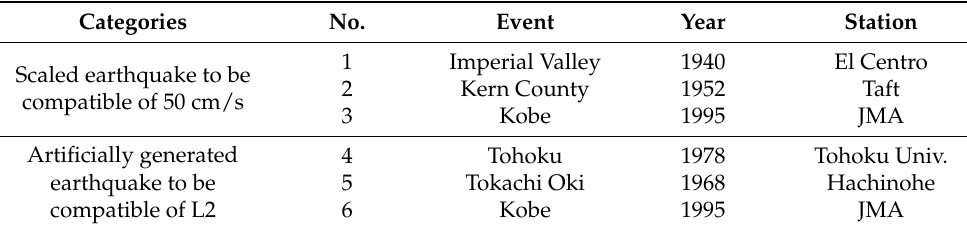
Table 8. List of selected earthquake ground